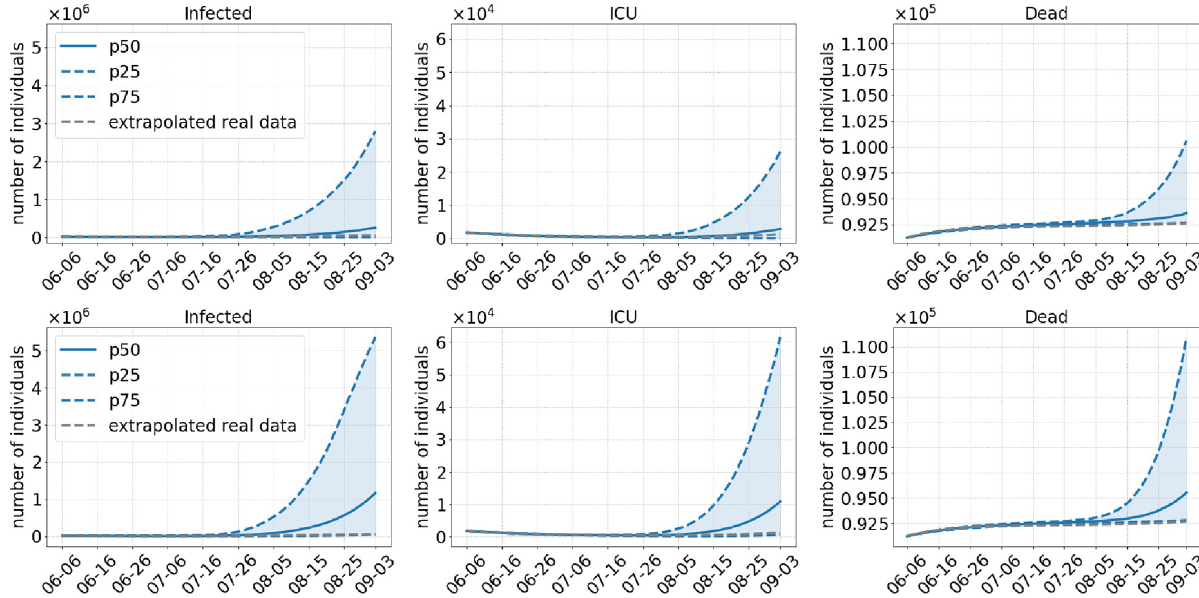
Fig 4. Results of Scenario 1: No commuter testing, local NPIs decreed until July 01, 2021 only, no masks after opening. The median of 500 runs is shown in solid blue; the blue dotted lines are the 25% and 75% percentiles. The top row shows results with an assumed 40% more transmissible Delta variant compared to 60% in the bottom